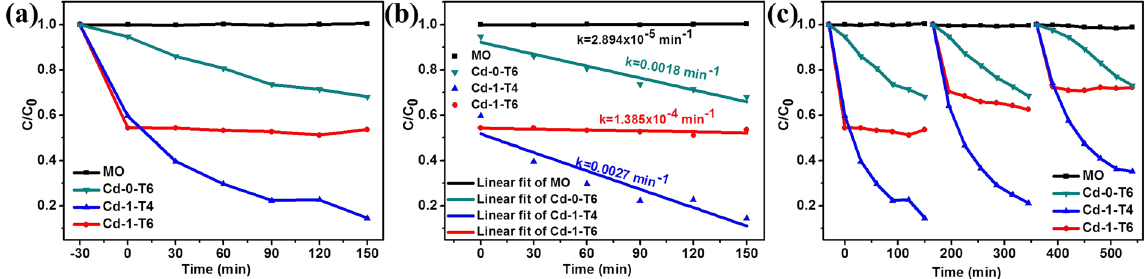
Figure 9. ( a ) Phtotodegradation of MO over as-prepared samples under visible light irradiation. ( b ) The first-order kinetic plot of ln( C/C 0 ) vs . time corresponding to the data in ( a ). ( c ) Catalysts recycling in the photodegradation of